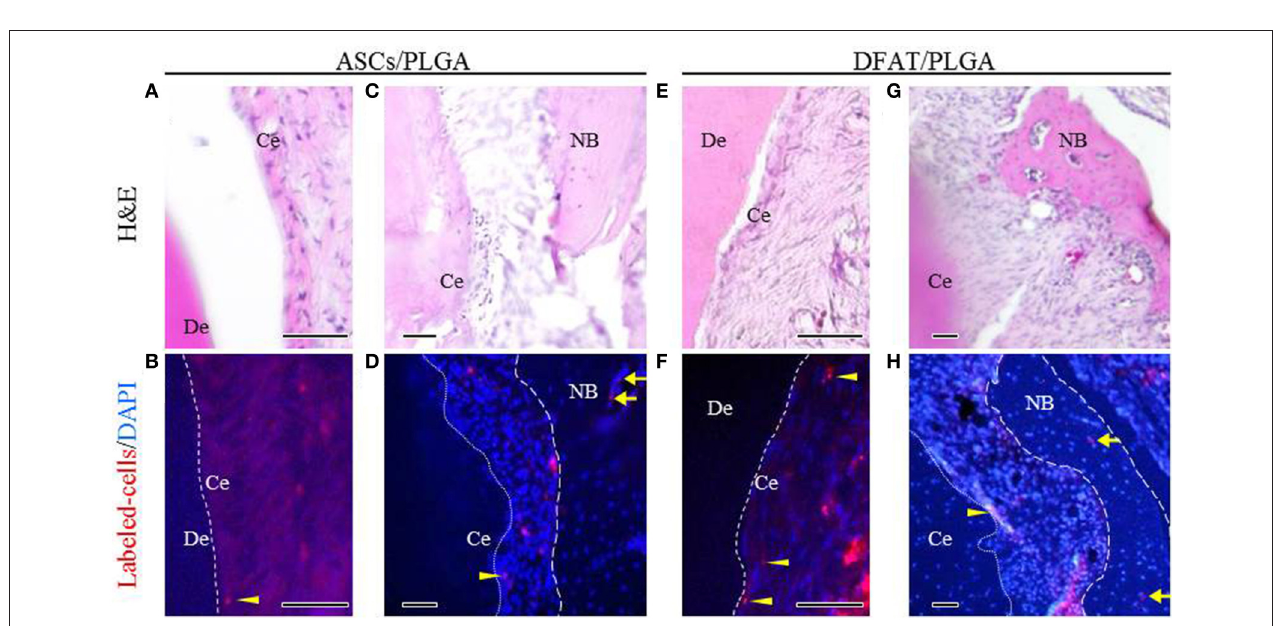
FIGURE 9 | Histometric analysis of newly formed cementum thickness, periodontal ligament width, and alveolar bone width. (A) In the central root of the first molar, the cementum in the DFAT/PLGA group was significantly thicker than that in the ASCs/PLGA and PLGA-alone groups. In the distal root of the first molar, there were no significant differences between DFAT/PLGA and ASCs/PLGA. (B) In the central root of first molar, the periodontal ligament of the DFAT/PLGA group was significantly wider than that of the ASCs/PLGA and PLGA-alone groups. In the distal root of first molar, there were no significant differences between DFAT/PLGA and ASCs/PLGA groups. (C) In the central root and distal root of the first molar, the alveolar bone in the DFAT/PLGA group was significantly thicker than in the ASCs/PLGA and PLGA-alone groups ( n = 12 , * P < 0.05 ).